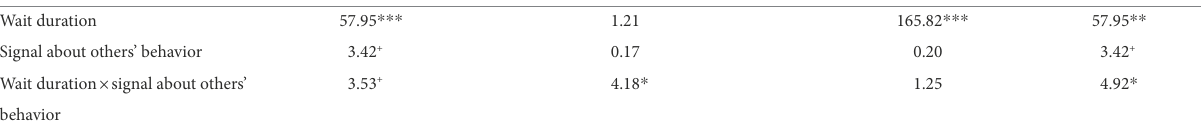
TABLE 5 Summary of analyses of the effects of wait duration and signal about others’ behavior on the number of number of snacks purchased, perceived wait length, and wait annoyance in Study 3b.